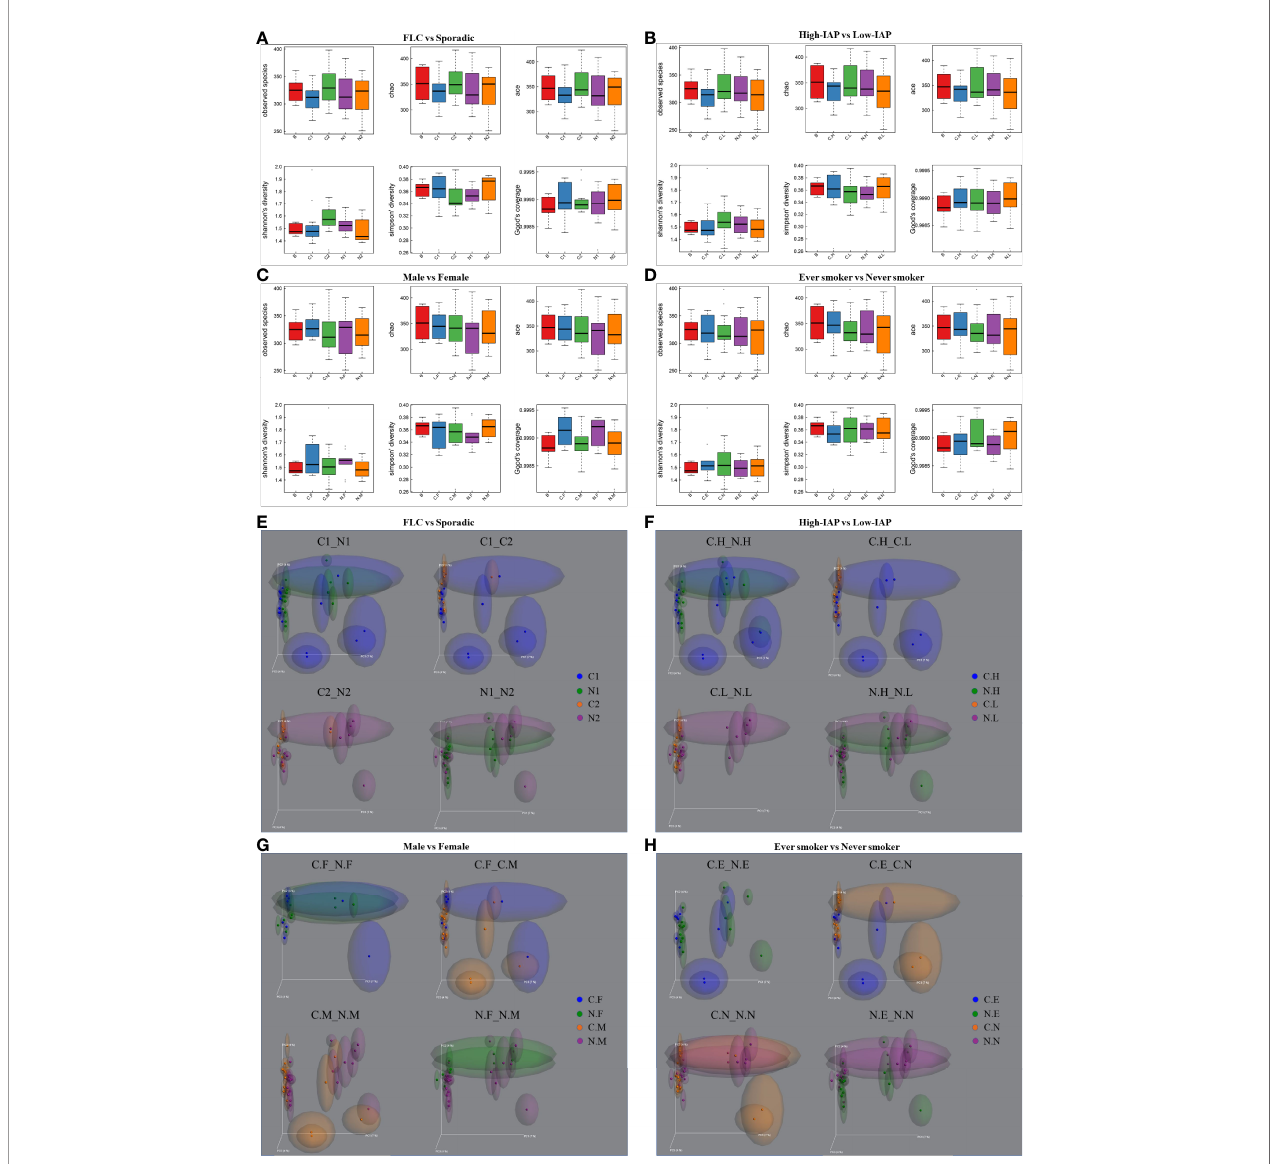
FIGURE 2 | The a -diversity and b -diversity of our subject population. The a -diversity included several indices: observed species, Chao, ace, Shannon, and Simpson. The complexity of the sample is proportional with the fi rst four values, while having a negative correlation with Simpson value. Observed species, Chao, and ACE value can re fl ect the species richness of the community. Shannon and Simpson values also re fl ect the species diversity of the community, affected by both specie richness and species evenness, that is the two values also consider the abundance of each species. With the same species richness, the greater the species evenness, the greater the community diversity; that is the bigger the Shannon or the smaller the Simpson value. The Good ’ s coverage index re fl ects whether the sequencing results represent the real situation of microbes in the sample. Here, all the groups had a coverage of around 0.999, appropriately re fl ecting the real situation of the sample ’ s microbiome. The a -diversity for four groups: (A) FLC vs Sporadic lung cancer; (B) High-IAP vs Low-IAP; (C) Female vs Male; (D) Smoker vs never smoker. Five lines from bottom to top is the minimum value, the fi rst quartile, mean, the third quartile, and the maximum value, and the abnormal value is shown as ‘ o ’ . In b -diversity, uniFrac uses the system evolution information to compare the composition of community species between samples. Since different microbes were detected in low abundance, b -diversity was analyzed by unweighted_unifrac, which didn ’ t calculate the abundance of sequences. The b -diversity for four groups: (E) FLC vs Sporadic lung cancer; (F) High-IAP vs Low-IAP; (G) Female vs Male; (H) Smoker vs non-smoker. Since all the samples were lung tissues, all of them had the same dominant phylum, genera, and species, that represented the basic microbiome of the organ lung. As a result, a -diversity and b -diversity based on all species did not reach statistical signi fi cance. Although not signi fi cant, visible differences could be found among subgroups. These differences are mainly caused by those in low abundance and subgroup-speci fi c microbes, even those ones not dominant; these microbes could still have their in fl uence on the lung microenvironment. C1/N1, cancer/normal tissue of familial lung cancer; C2/N2, cancer/normal tissue of sporadic lung cancer; C.H/N.H, cancer/normal tissue from high indoor air pollution region (High-IAP); C.L/N.L, cancer/normal tissue from low indoor air pollution region (Low-IAP); C.F/N.F, cancer/normal tissue of female lung cancer; C.M/N.M, cancer/normal tissue of male lung cancer; C.E./N.E, cancer/normal tissue from ever smokers; C.N/N.N, cancer/normal tissue from never smokers; B, benign